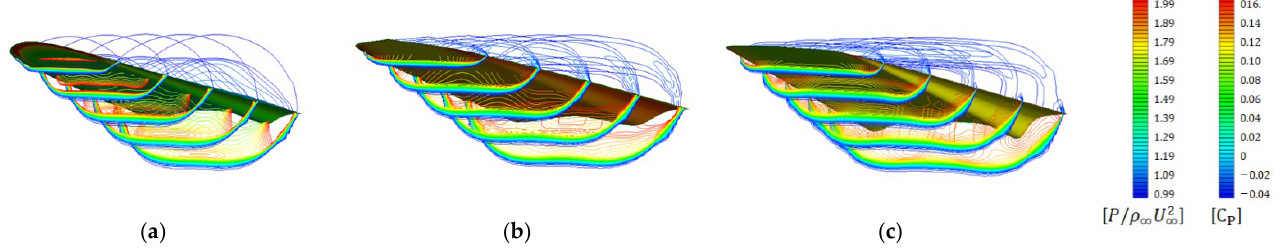
Figure 14. Computational fluid dynamics (CFD) results for optimal points and baseline configuration ( M ∞ = 5, altitude = 25 km ); ( a ) baseline; ( b ) optimum 1-minimal drag; ( c ) optimum 12-maximal volume.